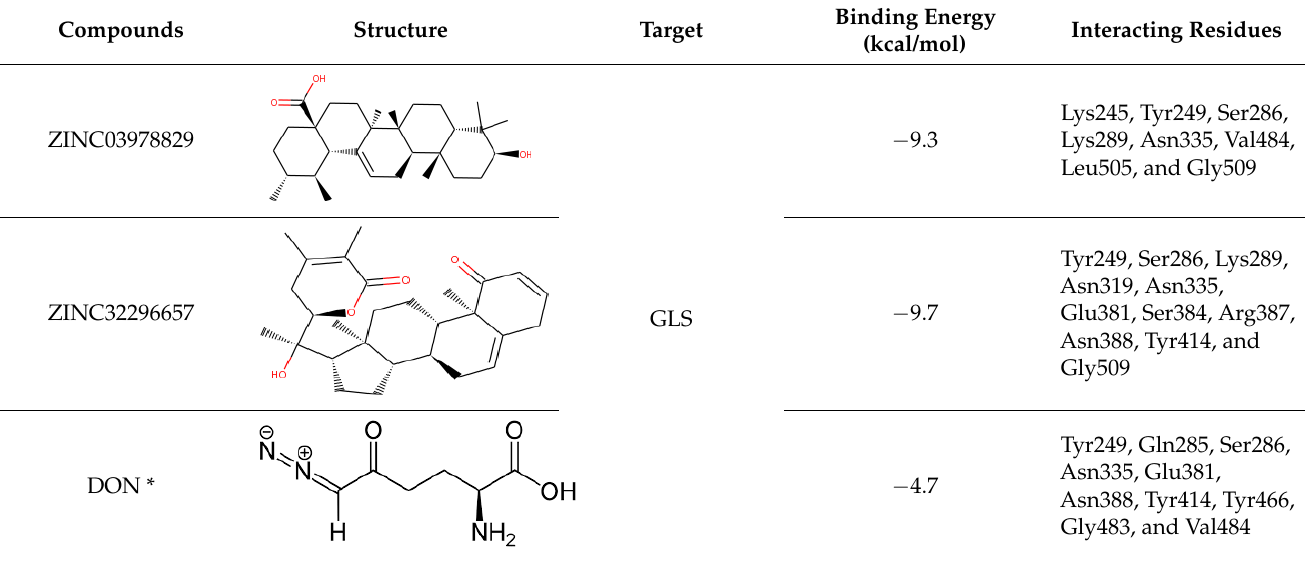
Figure 1. Visualization of ZINC03978829 (stick representation) in the binding pocket of GLS ( a ), interacting residues of GLS with ZINC03978829 ( b , c ). Table 3. BE and interacting residues of hits with GLS.